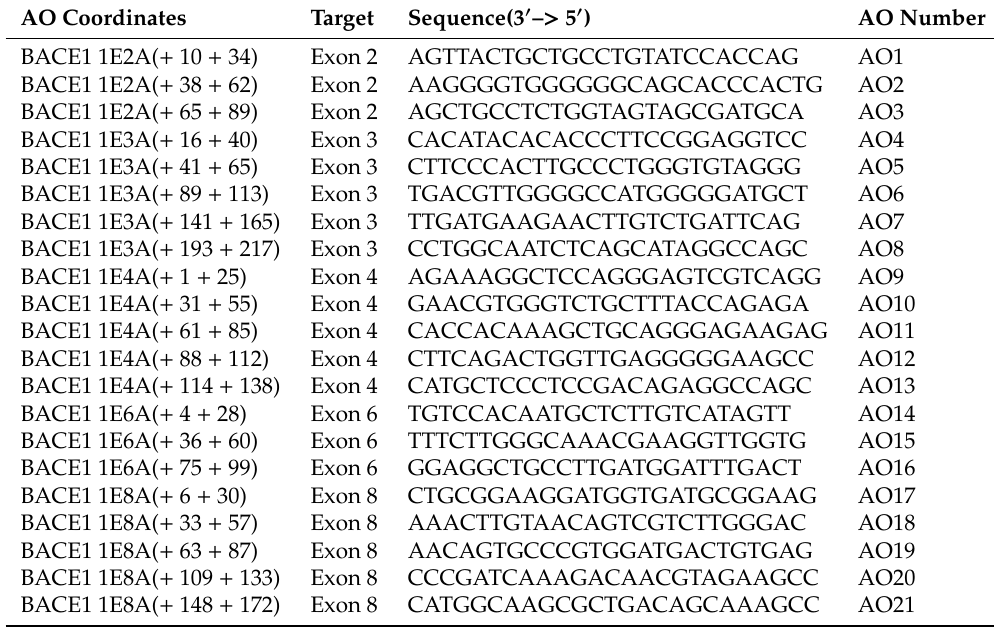
Figure 1. BACE1 exon map showing the size of the exons, as well as the intron size. Table 1. AO sequences targeting exons 2,3,4,6, and